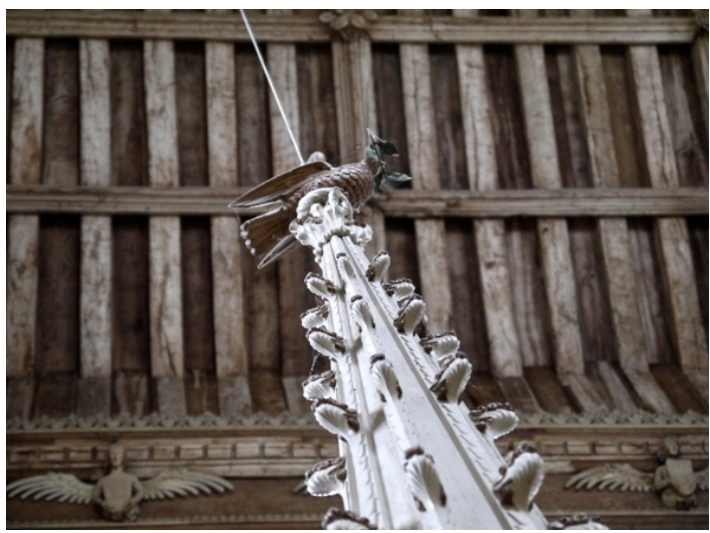
Figure 22. Bird on font cover of St Agnes of Cawston.